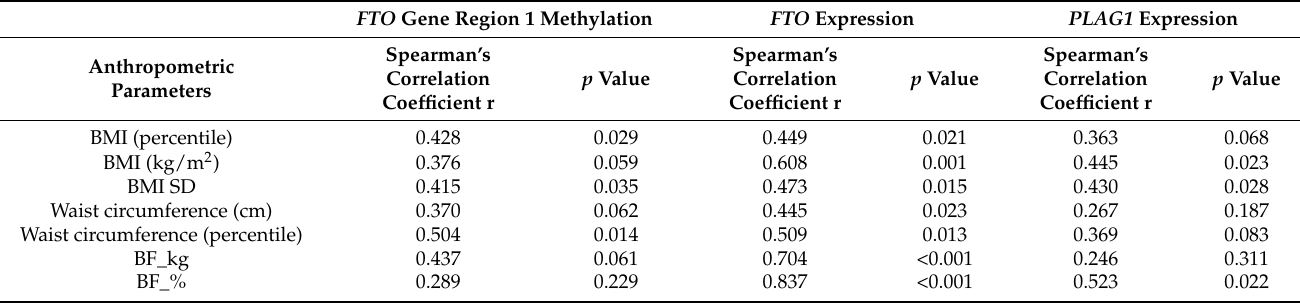
Table 3. Correlation results of anthropometric parameters with FTO gene methylation, expression, and PLAG1 gene